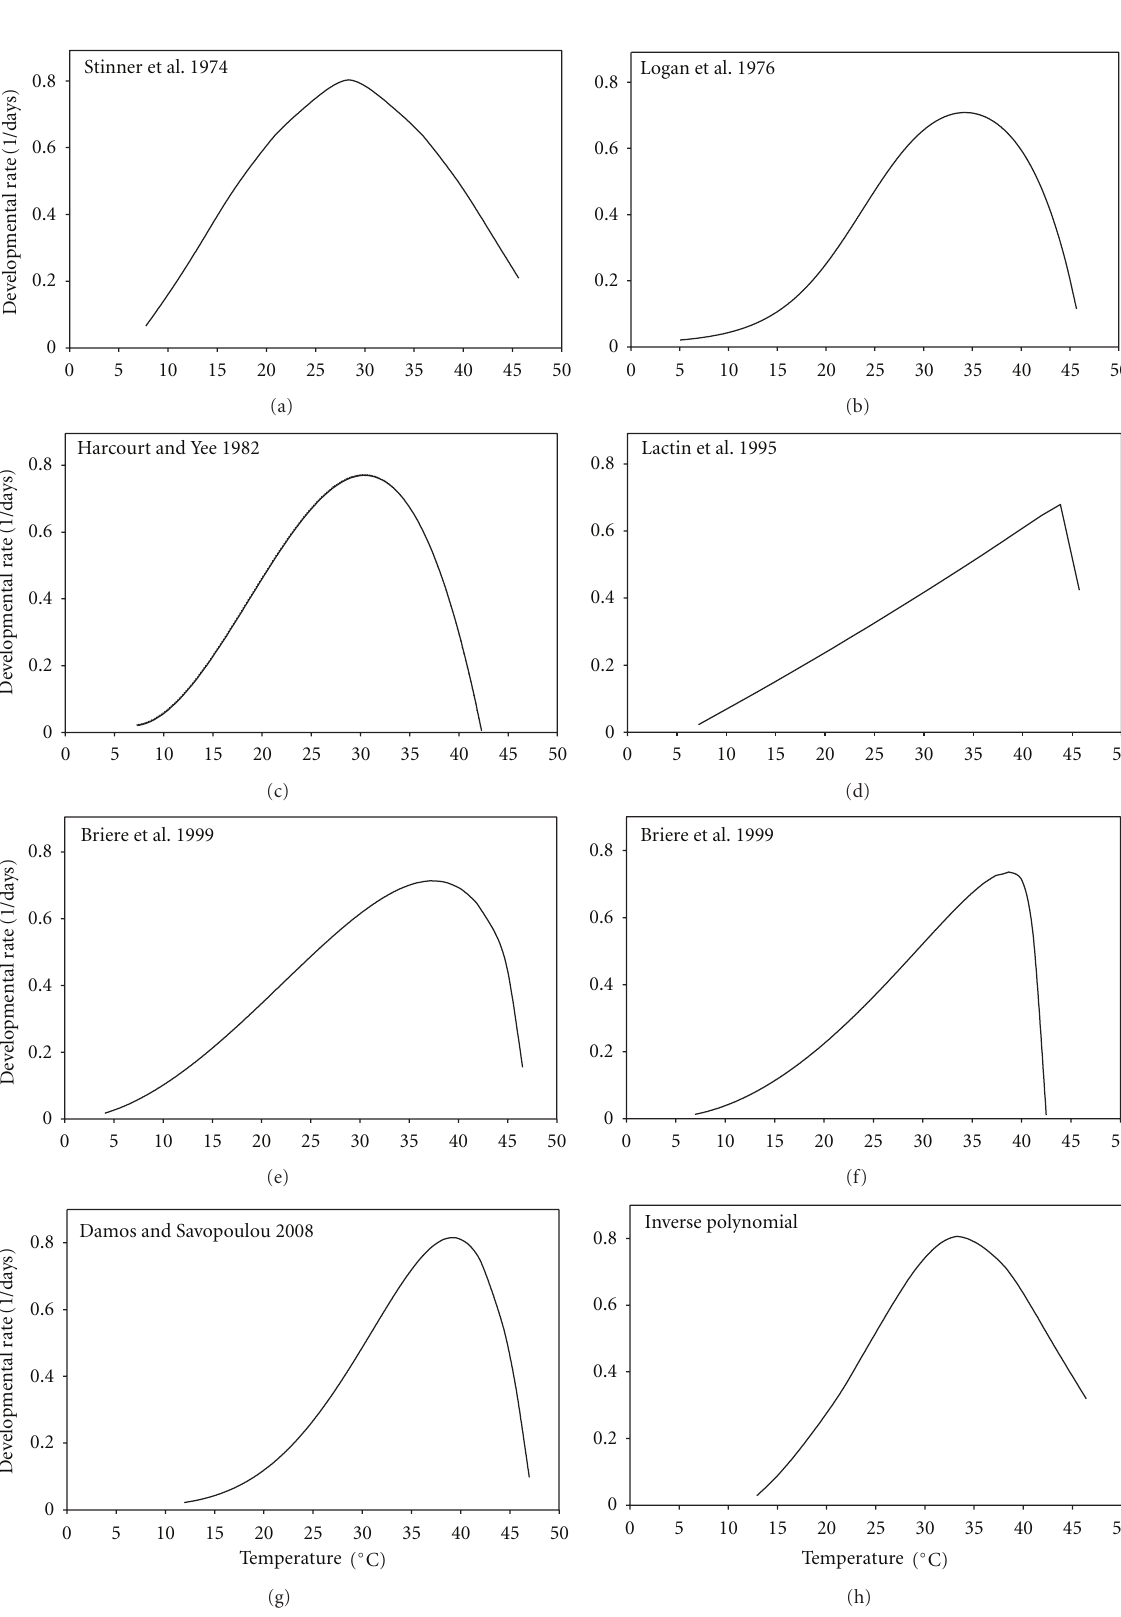
Figure 2: Typical relationships between temperature and insect developmental rates according to several representative non-linear